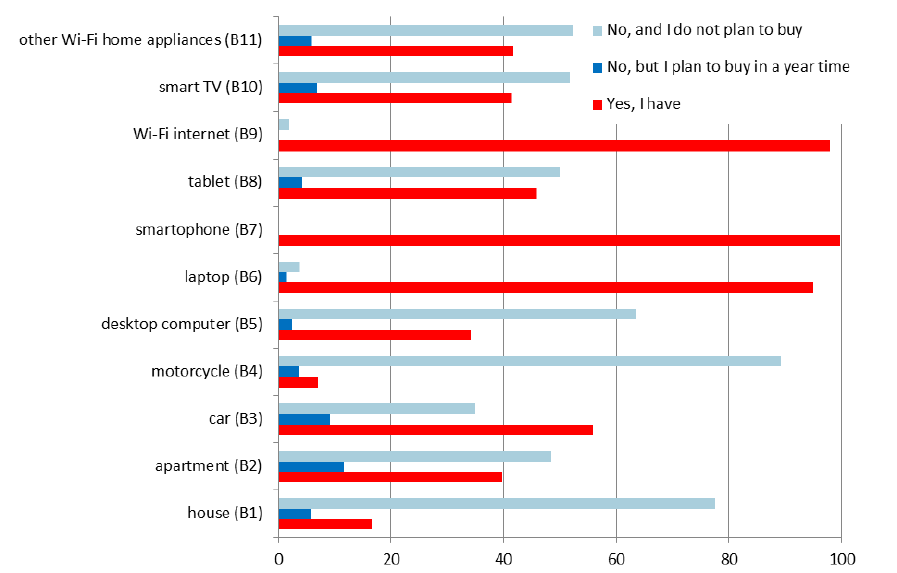
Figure 2. Distribution of respondents’ belongings of smart devices and personal